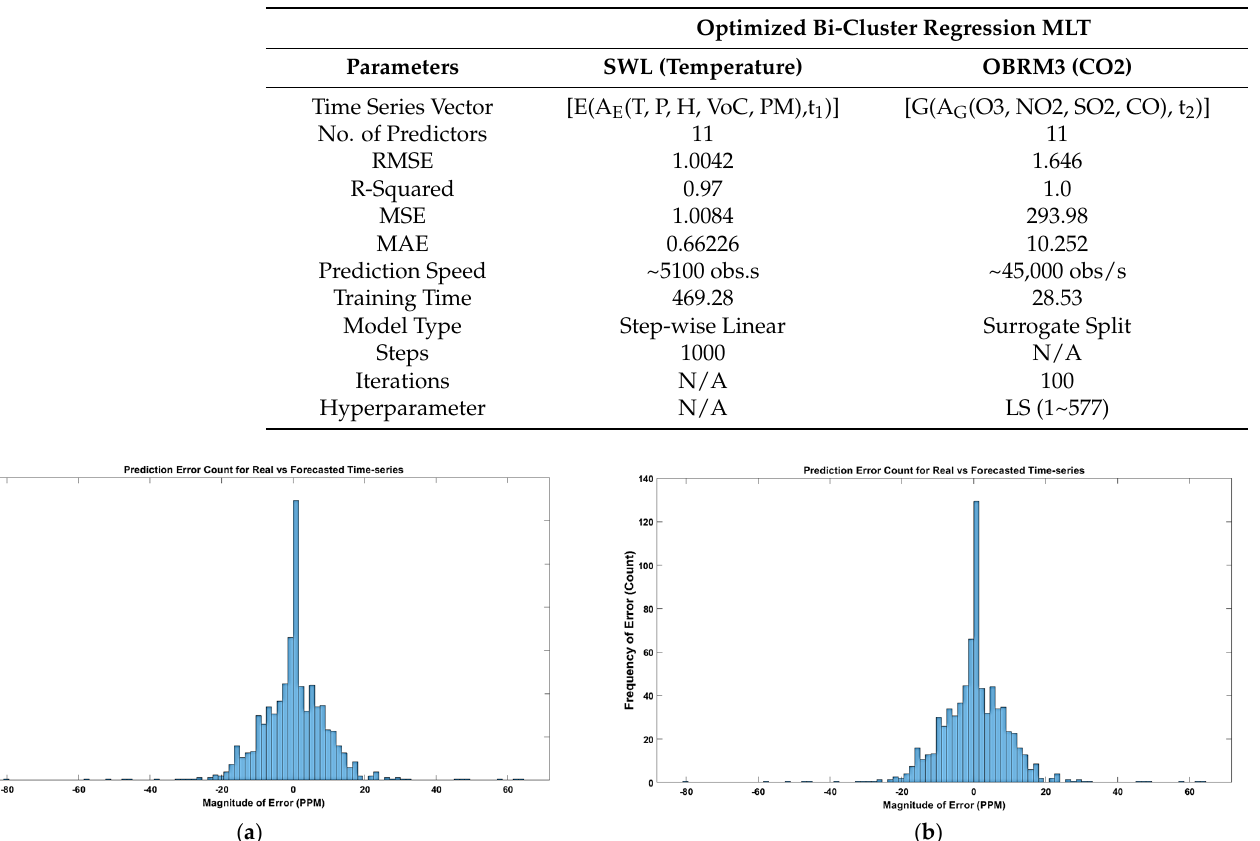
Table 4. Regression Parameter Setting.